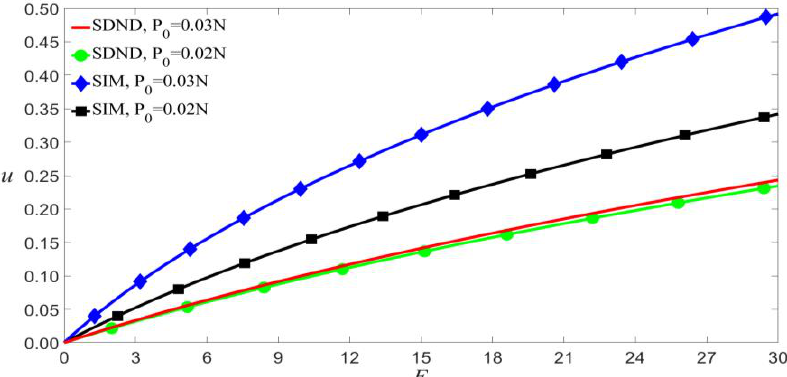
Figure 2. Impact of small-scale effect and initial axial load on the static bending of the microbeam for V DC = 1.5 V and V AC = 0.08